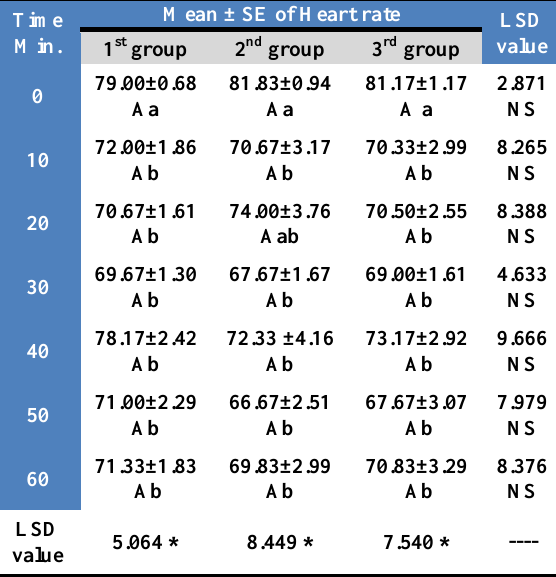
Table, 6: Effect of the three protocols on heart rate. Time